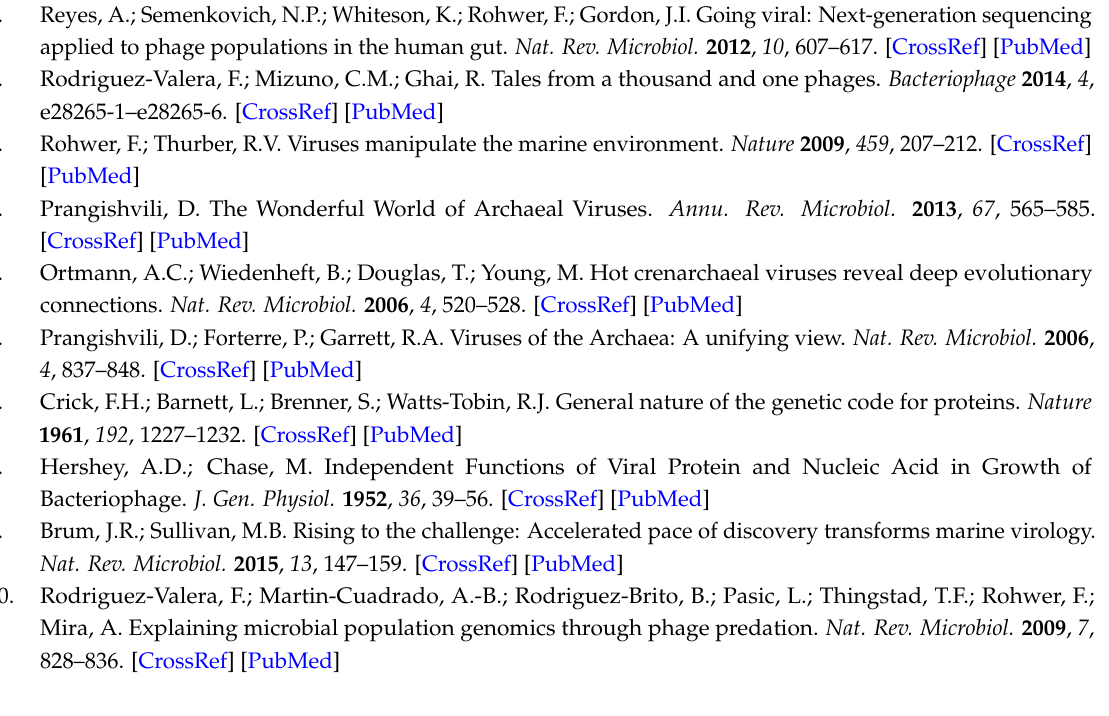
Figure S1: Electron Micrographs of SIRVs, Figure S2: Maximum Likelihood phylogenies of individual SIRV core genes that support biogeographic distribution, Figure S3: Maximum Likelihood phylogenies of individual SIRV core genes with incongruent topologies, Figure S4: Organization of variable gene clusters on Yellowstone SIRVs, Figure S5: Maximum Likelihood phylogenies of individual SIRV variable genes with 5 or more representatives, Figure S6: Maximum Likelihood phylogenies of genes implicated in SIRV resistance in S. solfataricus , Table S1: Environmental sample collection, Table S2: Host strain panel for virus purification, Table S3: Length, coverage, GC content and spacer match coverage of SIRVs, Table S4: SIRV core gene clusters, Table S5: Estimates of synonymous vs. non-synonymous substitutions and evolutionary divergence between sequences of each of the 30 SIRV core clusters, Table S6: SIRV variable gene clusters, Table S7: CRISPR spacer matches of S. islandicus strains against SIRVs with and without a protospacer associated motif (PAM), Table S8: Estimates of synonymous vs. non-synonymous substitutions and evolutionary divergence between S. islandicus sequences of two loci implicated in SIRV resistance in S. solfataricus , Table S9: Estimates of synonymous vs. non-synonymous substitutions between sequences SIRV variable clusters with 5 or more